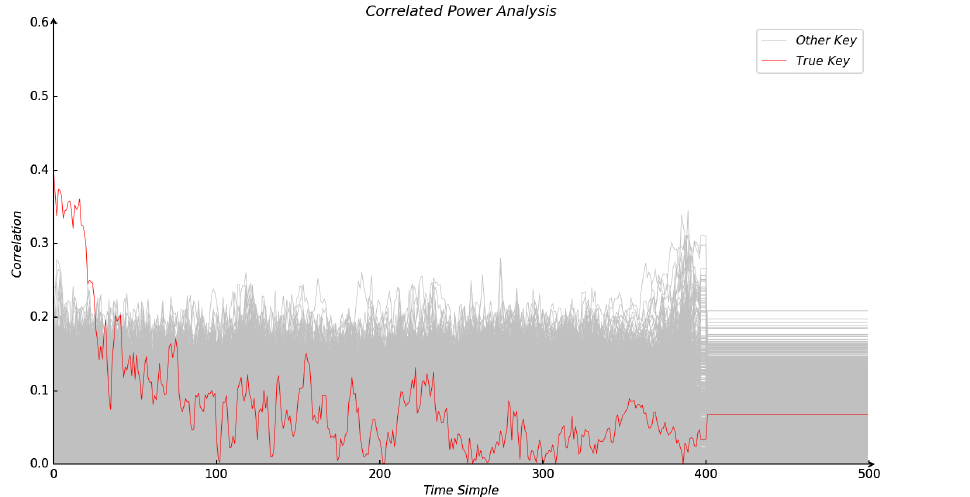
Figure 14. Group C: CPA result of experiment with 2 rounds calculated by software.